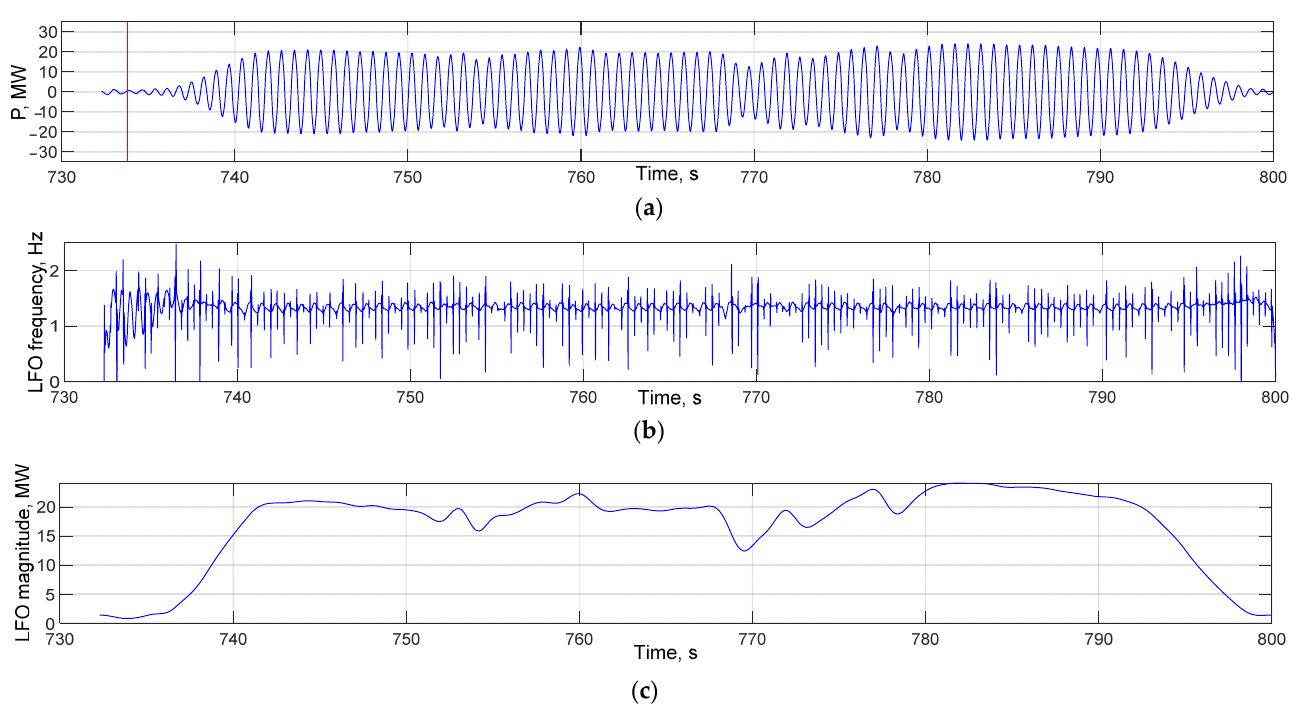
Figure 9. Sub ‐ interval 3, generator 6, active power: mode 1: ( a ) first mode signal; ( b ) LFO frequency; ( c ) LFO magnitude. Table 4. Results of LFO analysis.